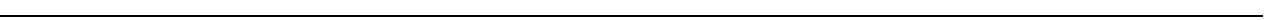
Fig. 6 Mirt2 attenuates LPS-induced endotoxemia. Endotoxemia was induced in C57BL/6 mice by intraperitoneal injection of LPS (25 mg/kg), and control animals were administered with equivalent volumes of normal saline. Adenovirus (Ad-Mirt2 or Ad-EV) were delivered into mice by tail veil injection 3 days before LPS challenge. a Adenovirus infection ef fi ciency at 72 h after adenovirus administration. b Survival curve of mice with endotoxemia (n = 12). c Levels of cytokines (IL-1- β , IL-6 and TNF) in serum of mice challenged with LPS for 6 h. Data are expressed as mean ± SEM (n = 8). * P < 0.05 vs. Ad-EV group. d Histopathology in lung of Ad-EV or Ad-Mirt2 treated mice 24 h after LPS challenge. Upper panel: Hematoxylin and eosin staining; Middle panel: Immunohistochemical staining for macrophage marker F4/80; Lower panel: Immunohistochemical staining for neutrophil marker Ly6G. e Quantitative analysis of lung injury in panel d . Left panel: Lung injury score; Middle panel: Quantitative analysis of F4/80 positive cells; Right panel: Quantitative analysis of Ly6G positive cells. Data are expressed as mean ± SEM (n = 8). * P < 0.05 vs. Ad-EV group. f Western blot analysis for the phosphorylation of p65 and Jnk in lung of endotoxemia mice. g Quanti fi cation of band density in panel f . Data are expressed as mean ± SEM ( n = 5). * P < 0.05 vs. Ad-EV group. h Histopathology in liver of Ad-EV or Ad-Mirt2 treated mice 24 h after LPS challenge. Upper panel: Hematoxylin and eosin staining; Middle panel: Immunohistochemical staining for macrophage marker F4/80; Lower panel: Oil Red O staining. i Quantitative analysis of liver injury in panel h. Left panel: Liver injury score; Middle panel: Quantitative analysis of F4/80 positive cells; Right panel: Determination of the contents of triglyceride. Data are expressed as mean ± SEM ( n = 8). * P < 0.05 vs. Ad-EV group. j Western blot analysis for the phosphorylation of p65 and Jnk in liver of endotoxemia mice. k Quanti fi cation of band density in panel j . Data are expressed as mean ± SEM ( n = 5). * P < 0.05 vs. Ad-EV group. Two-tailed Student ’ s t -test for two